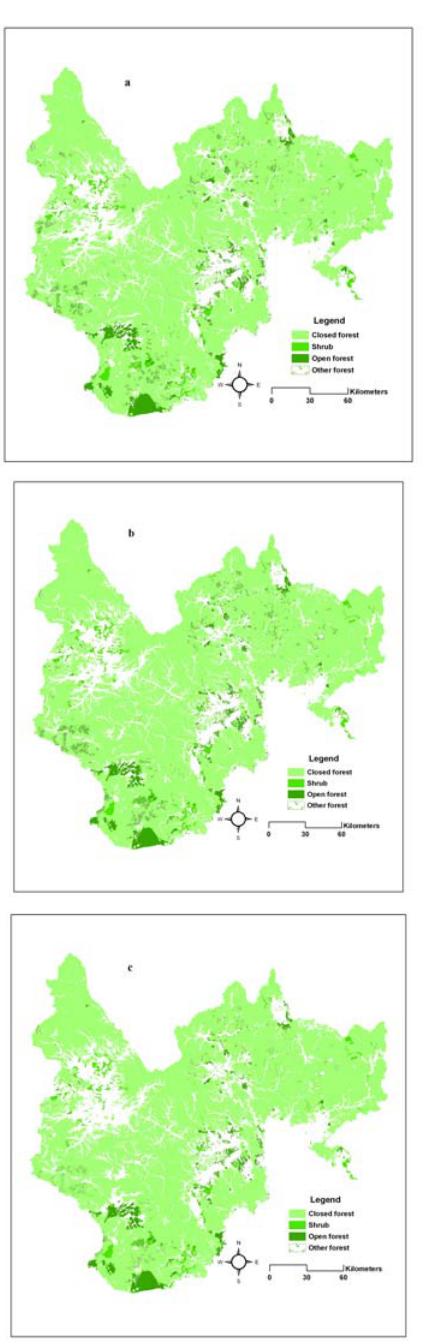
Table 1. The area changes of different forest types (km 2 )